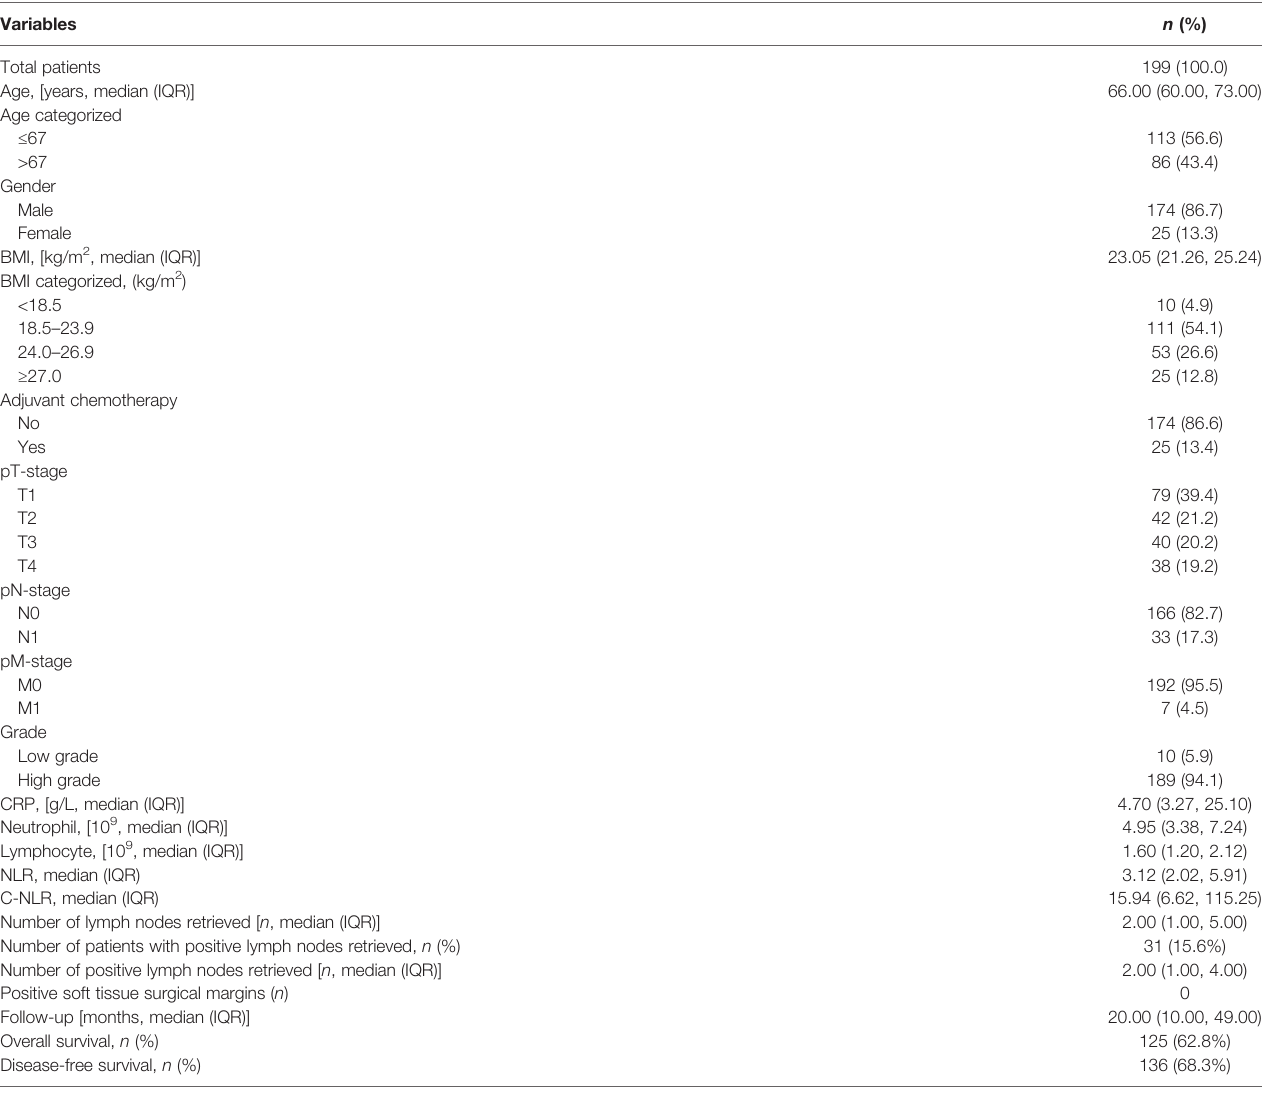
TABLE 1 | Baseline characteristics of included BC